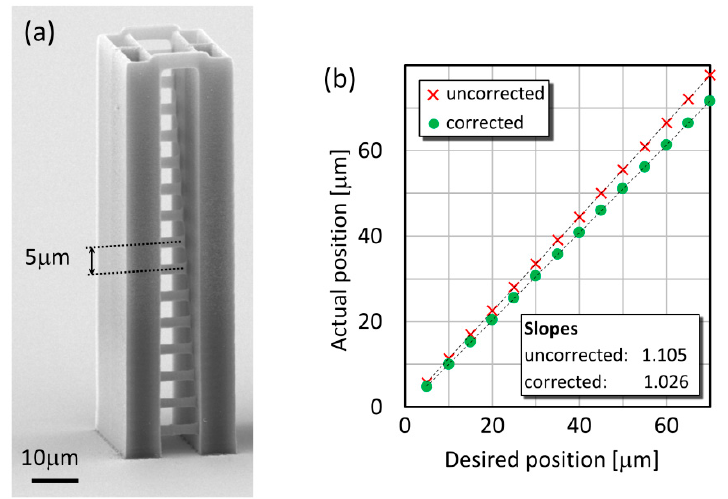
Figure 3. Test lines at various positions above the glass surface. Electron microscopic image of a test structure for the measurement of the geometrical features ( a ). Actual test line positions for the 170 µ m glass with and without SA correction ( b ).